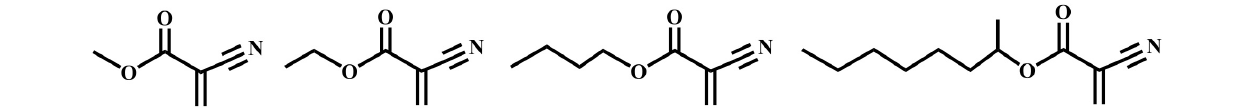
FIGURE 1 | Cyanoacrylate monomers for tissue adhesives, including methyl-cyanoacrylate, ethyl-cyanoacrylate, butyl cyanoacrylate and octyl cyanoacrylate. Reproduced from Singer et al. (2008) with permission from Copyright 2008